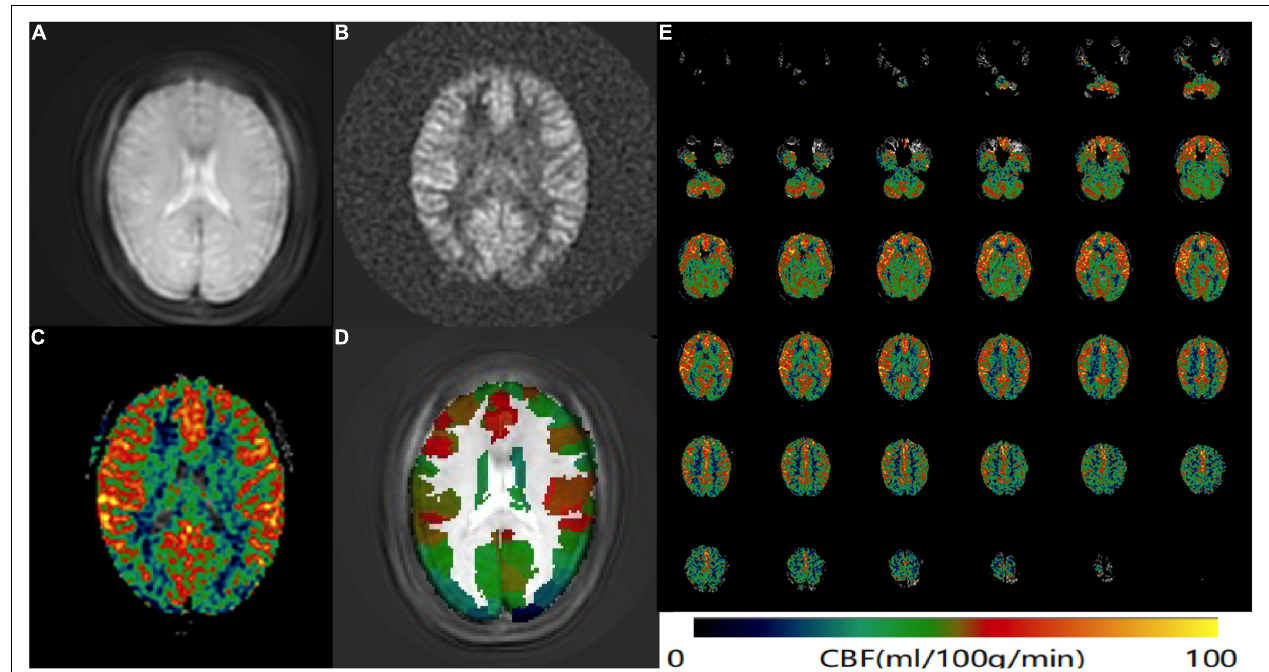
FIGURE 1 | ASL data processing workflow. Convert the (A) 3D ASL proton density images and (B) perfusion weighted images into the CBF map of cerebral perfusion for each subject. (C) The CBF map was normalized to the MNI space and then the BNA was overlaid. (D) The average CBF value of each brain region from BNA was obtained. (E) An example CBF map of a female SSNHL patient calculated by Cereflow software.